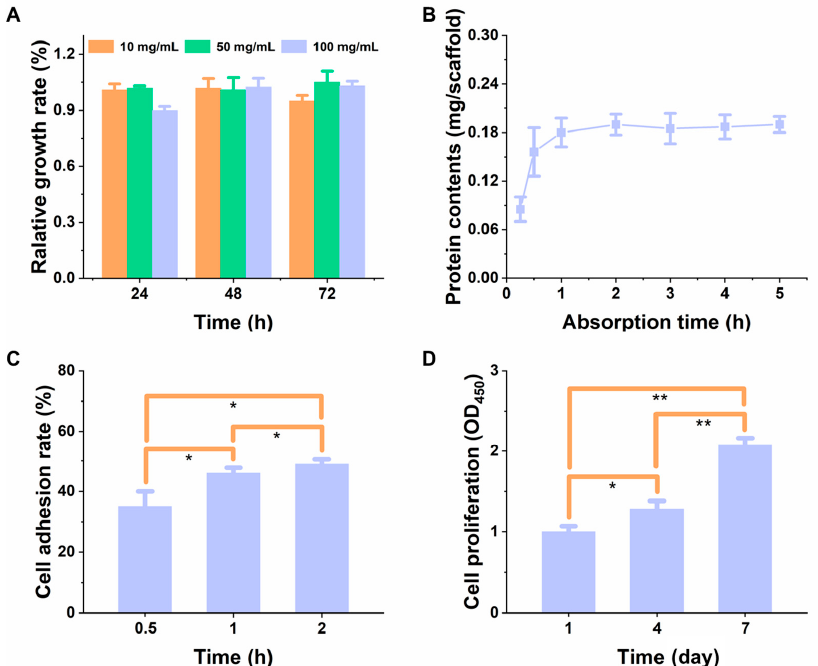
Figure 8. ( A ) The relative growth rate of L929 cells on the PLGA scaffold. The concentrations of the scaffold leaching solution were 10, 50, and 100 mg/mL, respectively. ( B ) Protein adsorption efficacy onto the scaffold at different time intervals. ( C ) Cell adherence rate and ( D ) proliferation rate on the scaffold, at different time intervals, ( n = 5). * represents p < 0.05, ** represents p < 0.01.